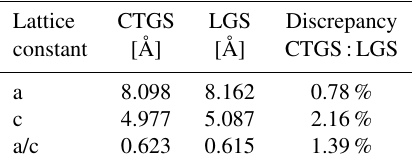
Table 2. Target compositions and according abbreviations used in this work.